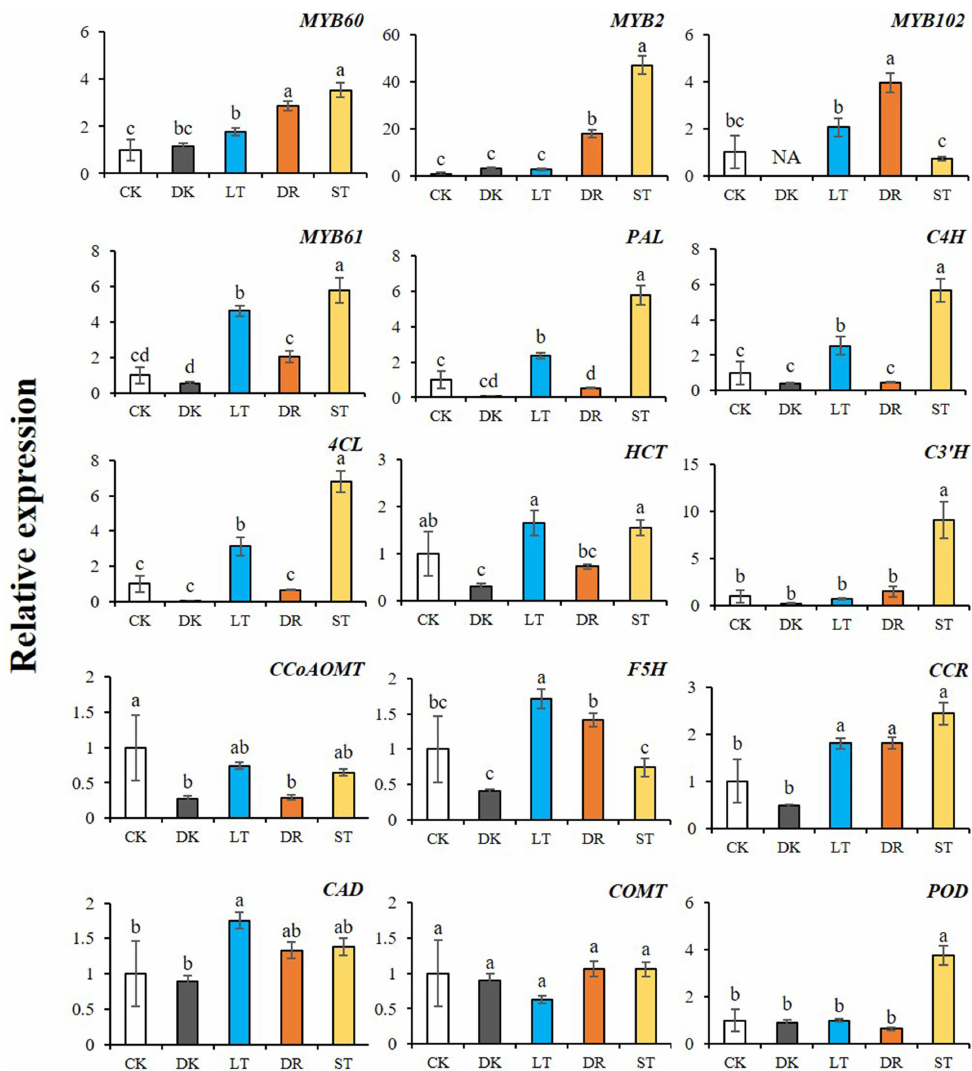
Figure 10. Relative expression levels of AcMYBs and lignin-biosynthesis-related genes in kiwifruit under different stresses. CK. control, DK. dark, LT. low temperature, DR. PEG simulation of drought, ST. salt. Different superscript letters indicate significant differences between different treatments at p < 0.05 level. NA indicates that the expression level is lower than the minimum value detectable by the instrument.